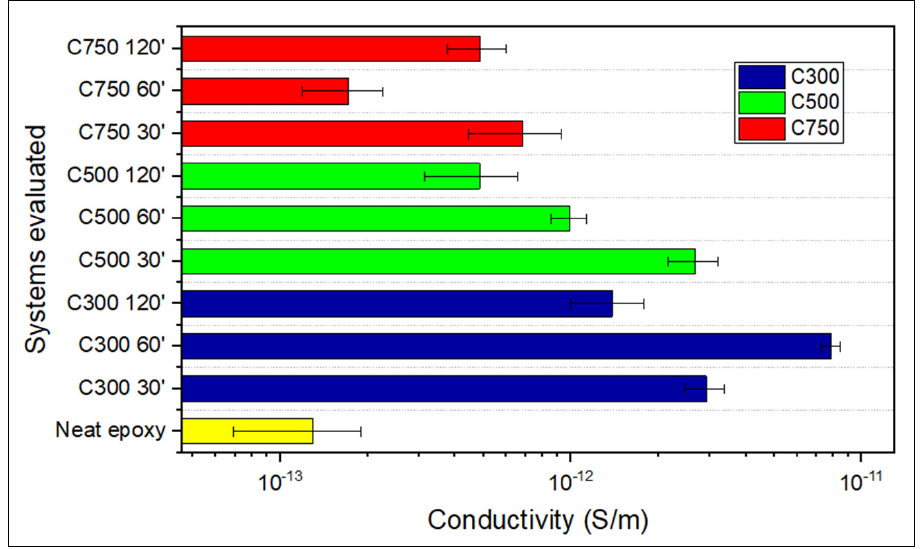
Figure 8. Electrical conductivity in the Z-direction of GNP/epoxy composites.